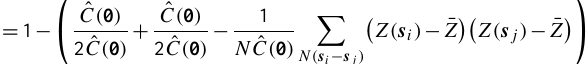
Fig. 2. Correlogram estimation using the fast Fourier transform. (a) One-dimensional section through the radar comopsite for test case 3 (6.33–8.13 ◦ W at 46.39 ◦ N; mm), (b) centered and zero-padded data, (c) normalized power spectral density in wrap-around order, (d) nonparametric estimate of the correlation function. Lags are in km .